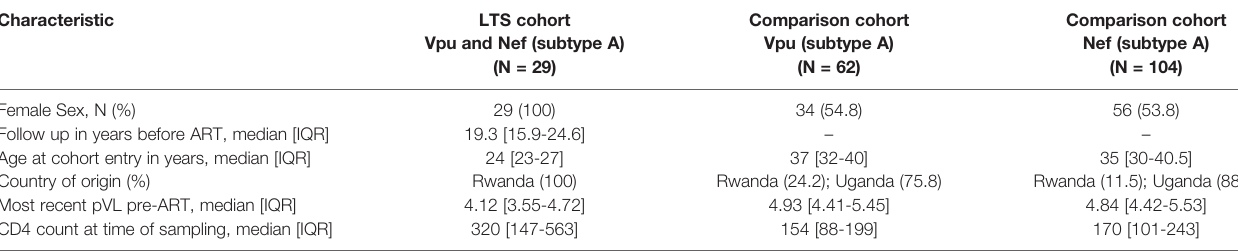
TABLE 1 | Characteristics of Rwandan long-term survivors and controls. Characteristic LTS cohort Comparison